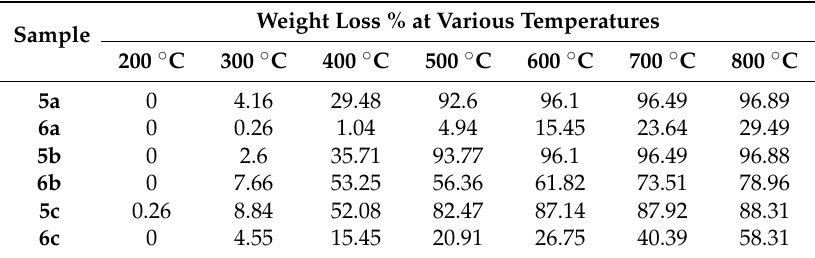
Figure 4. TGA graphs of 5a and 6a , 5b and 6b and 5c and 6c .